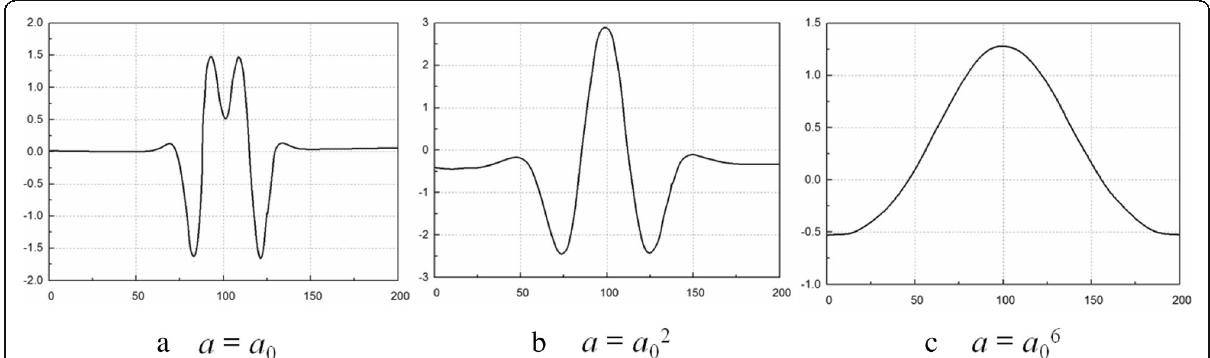
Fig. 4 Cross section of in each wavelet coefficient signal when b =